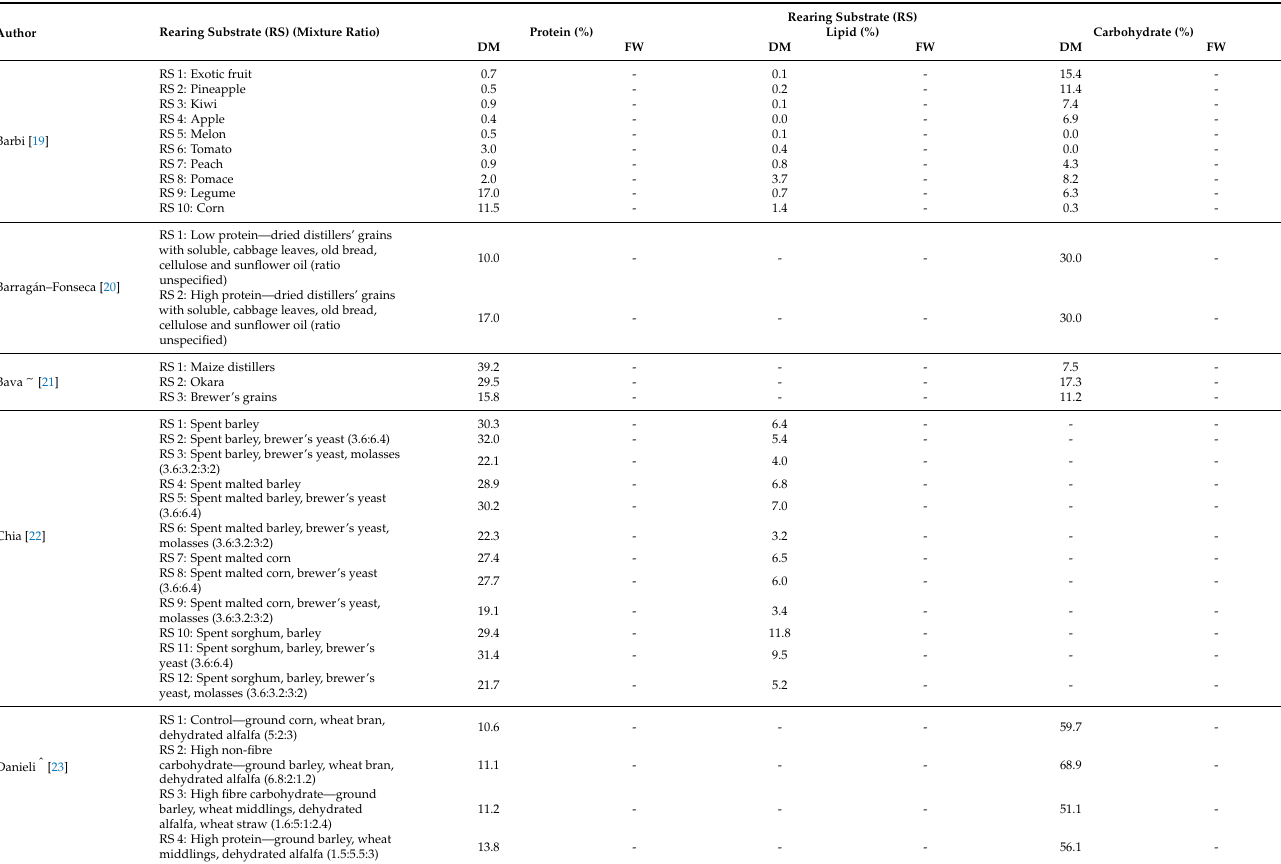
Table 2. Macronutrient Composition of Rearing Substrates (RS).